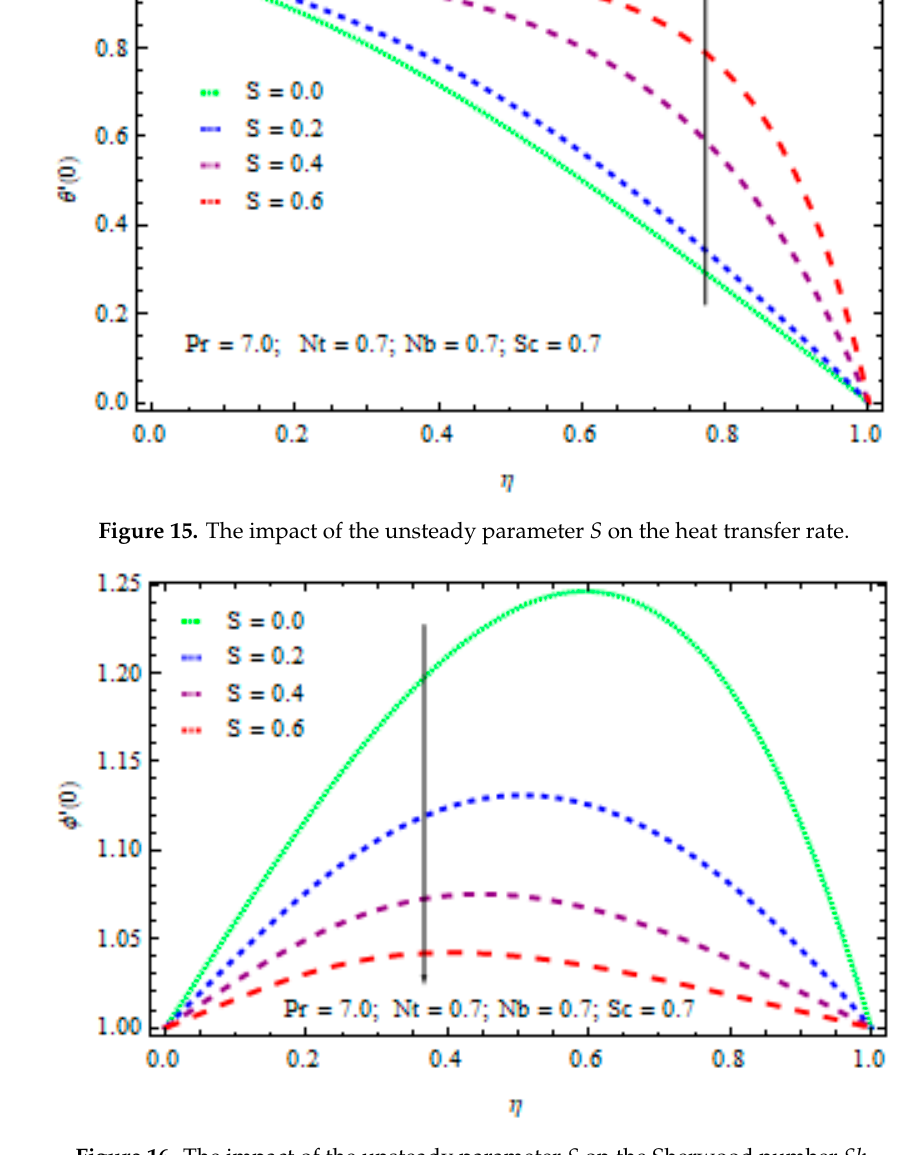
Figure 16. The impact of the unsteady parameter S on the Sherwood number Sh .